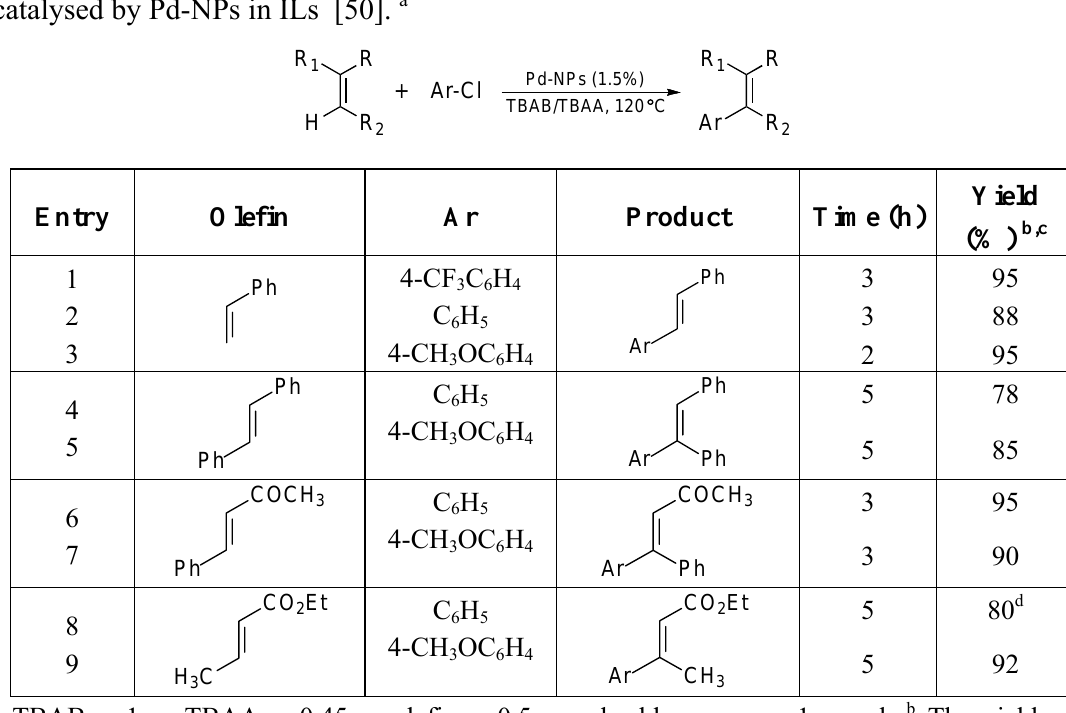
Table 1. Selected examples for the coupling of deactivated olefins with aryl chlorides catalysed by Pd-NPs in ILs [50]. a